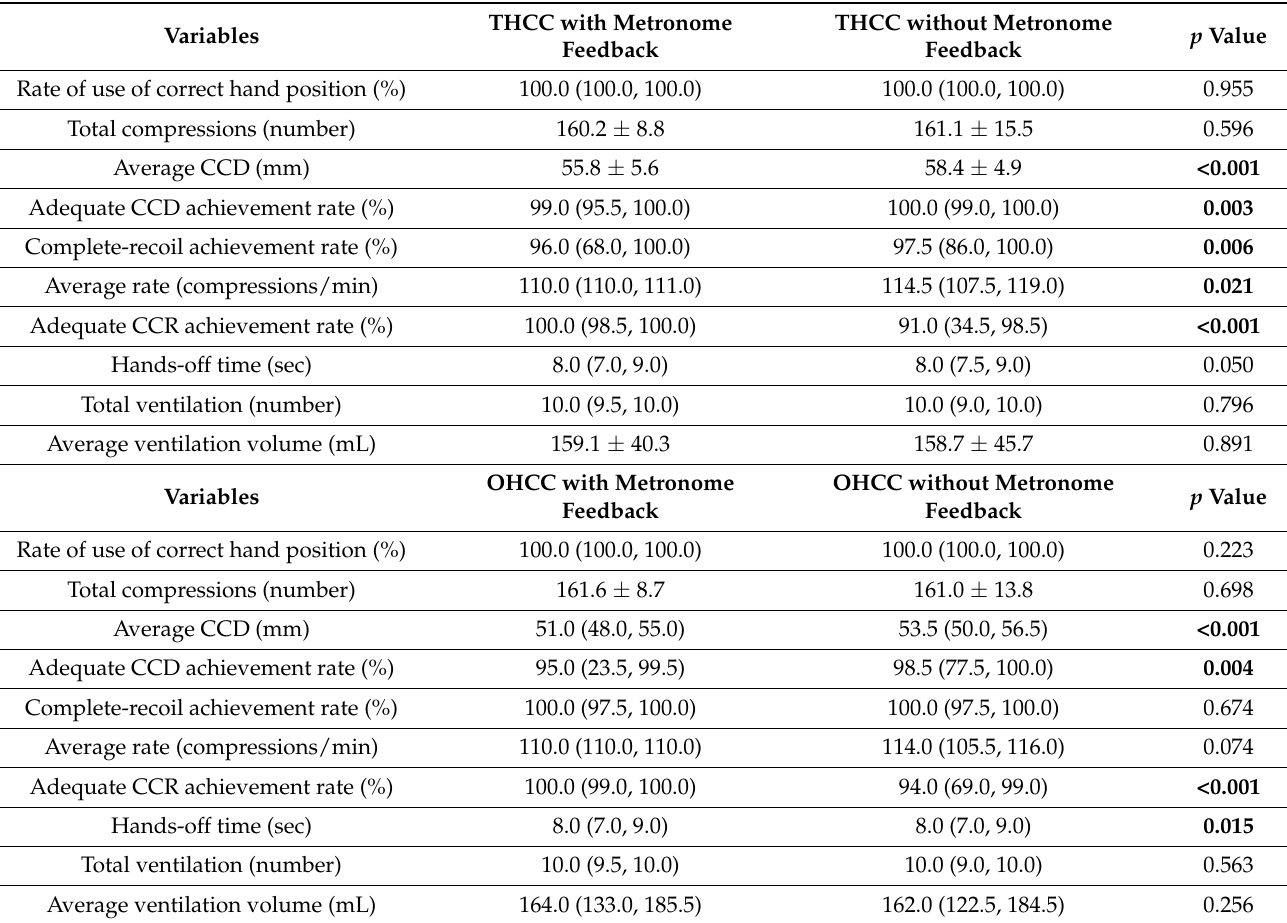
Table 1. Comparison of variable values for cardiopulmonary resuscitation performed with and without metronome feedback.